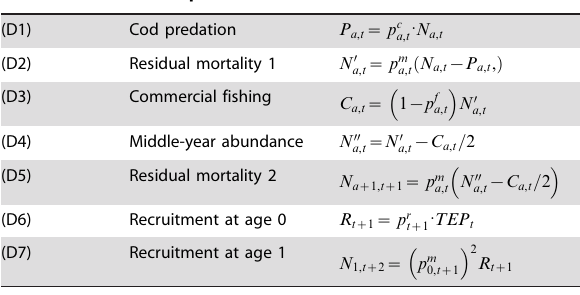
Internal stochastic processes: projection